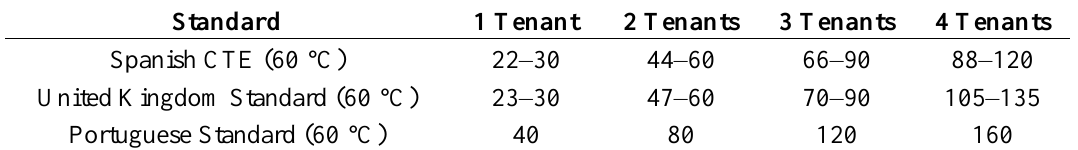
Table 5. Amount of DHW (LPCD) using different standards.